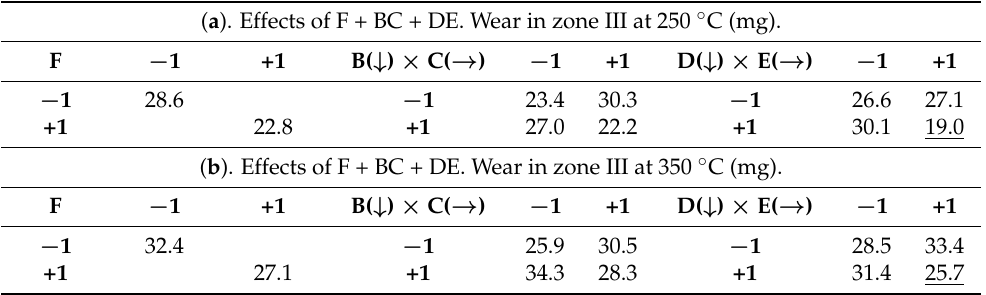
Table 13. Analysis of the effect of factor F and interactions BE +